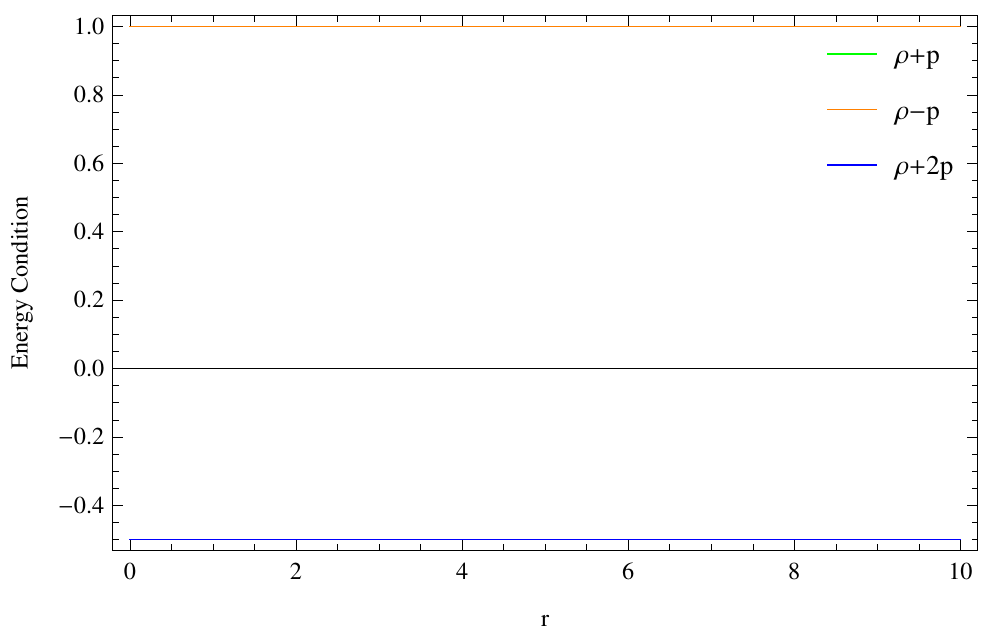
Figure 14. The energy conditions for dark energy matter source are shown against the radial parame- ter r with the values of arbitrary constants C 3 = 2, C 4 = 0.001, C 5 = 10. The cosmological constant, expressed as a function of r , i.e., Λ = Λ ( r ) , is deduced from Equations (16) and (17) as (shown graphically in Figure 15).